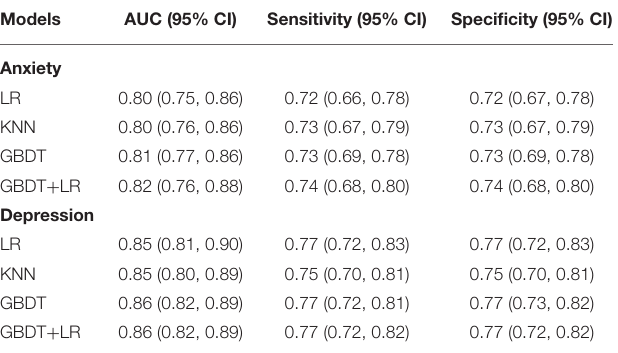
TABLE 2 | Evaluation of the four machine learning algorithms for anxiety and